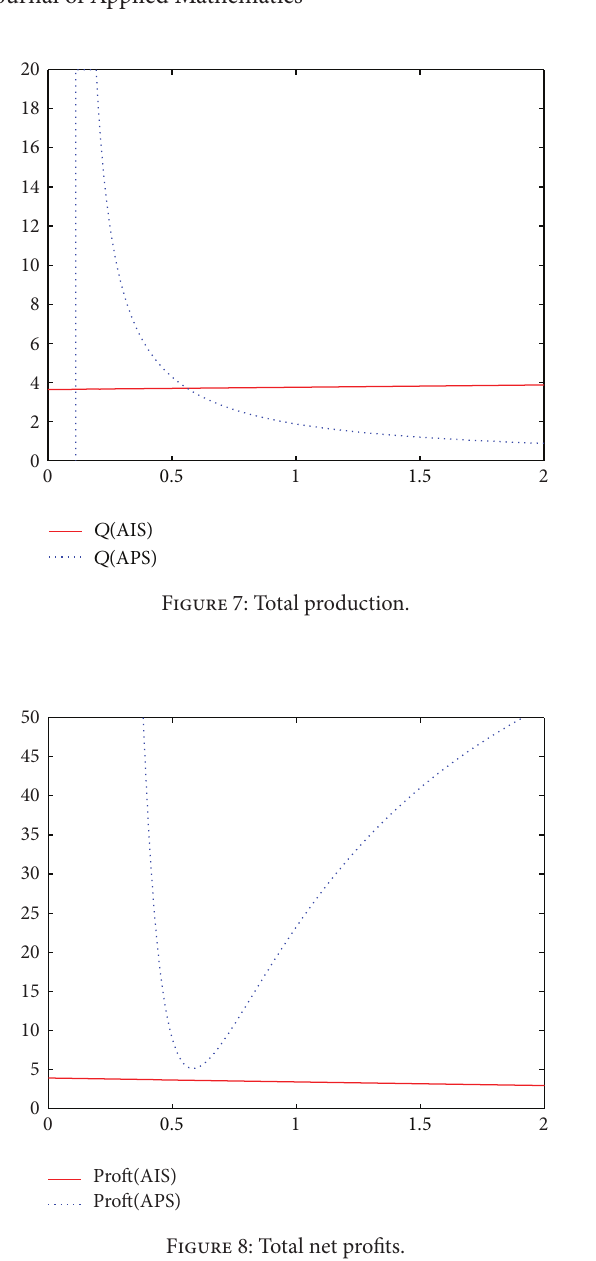
Figure 8: Total net profits.